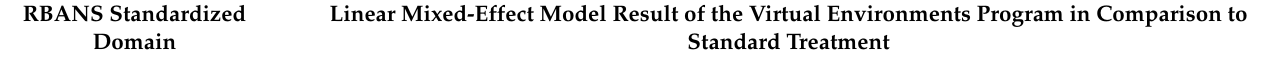
Table 3. The effect of the intervention (standard treatment/VEs program) on cognitive performance. The beta signifies the effect of the VE program on normalized score in the given domain while controlling for the session and participant effects.